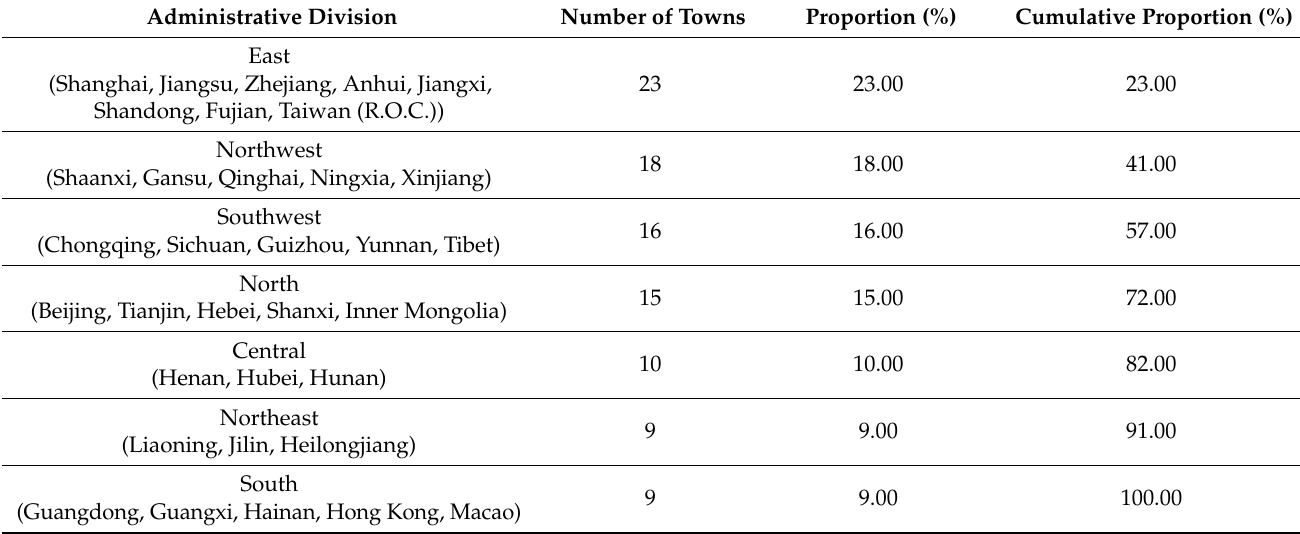
Table 4. Statistical distribution of rural tourist towns in the seven geographical regions of